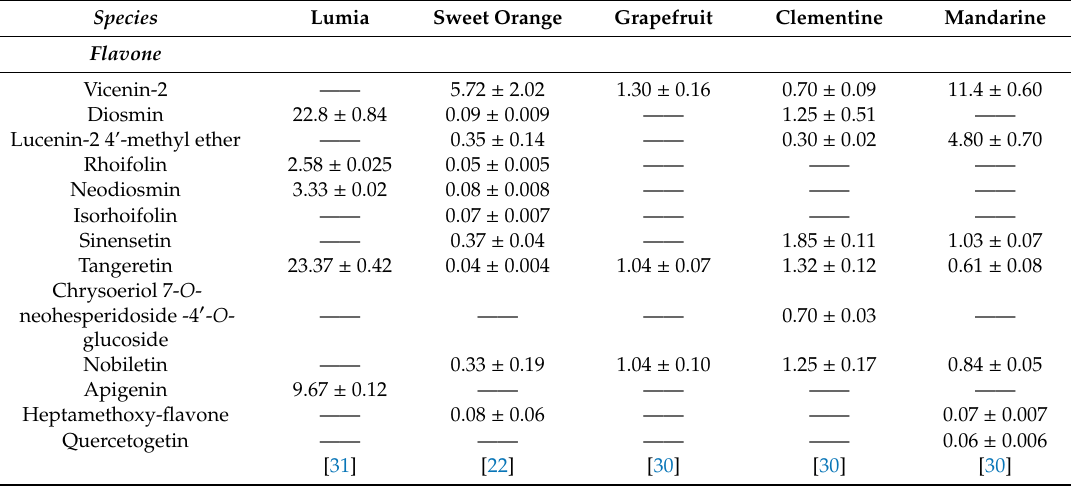
Table 6. Flavone content in lumia ( Citrus lumia Risso and Poit.) , sweet orange ( Citrus sinensis ), grapefruit ( Citrus paradise ), clementine ( Citrus clementina ), and mandarin ( Citrus reticulata ). Species Lumia Sweet